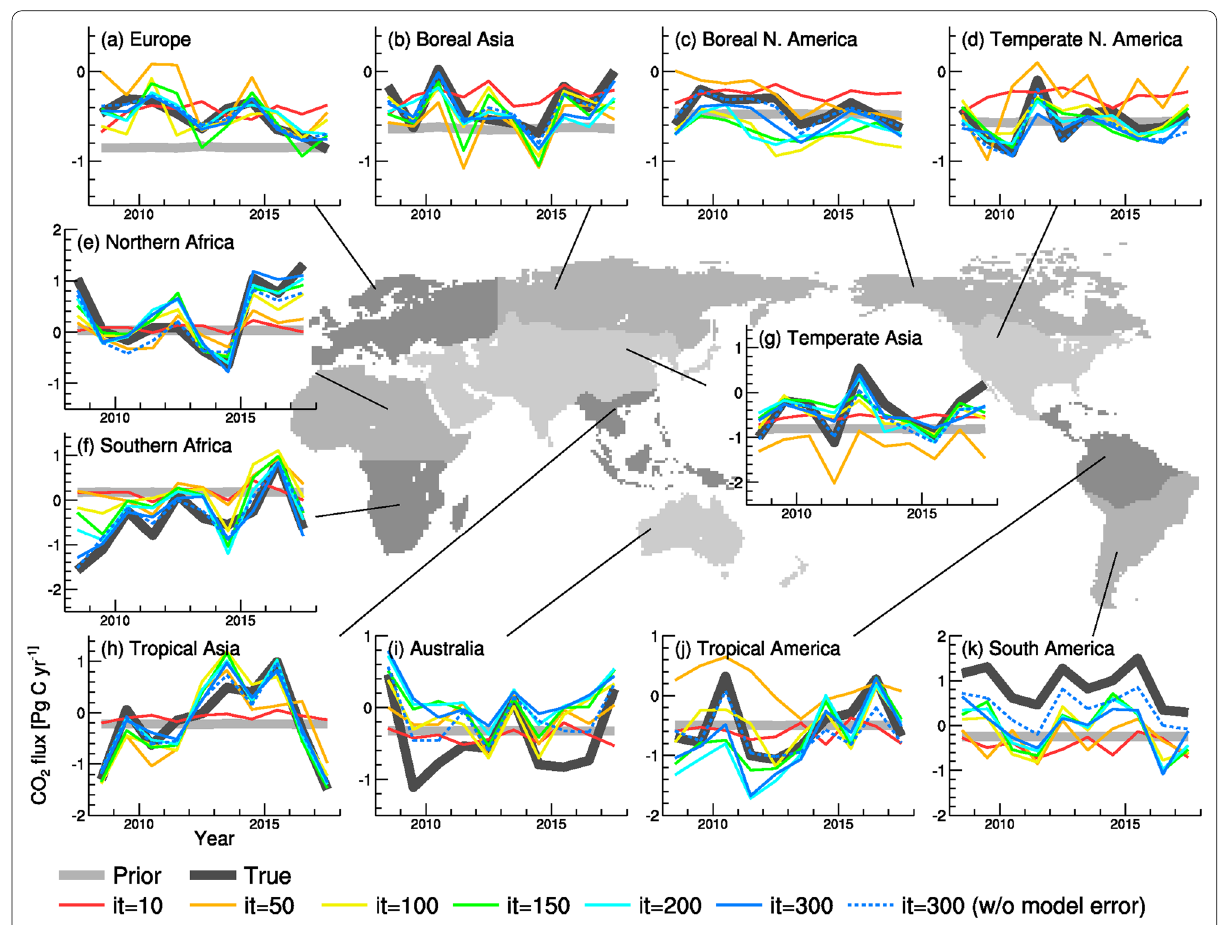
Fig. 8 Same as Fig. 7, but for yearly variations from 2008 to